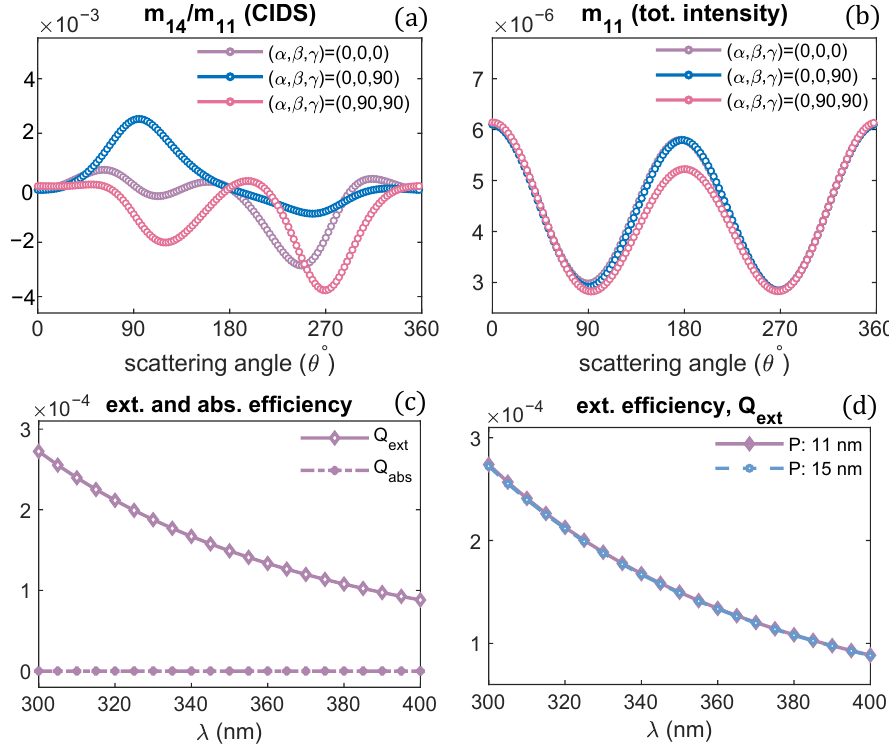
Figure 3. ( a , b ) CIDS and total intensity angular dependence for different orientations of solenoid, λ = 300 nm, ( c ) extinction and absorption efficiency of chromatin fiber with pitch 11 nm, ( d ) extinction efficiency of solenoid for different pitch